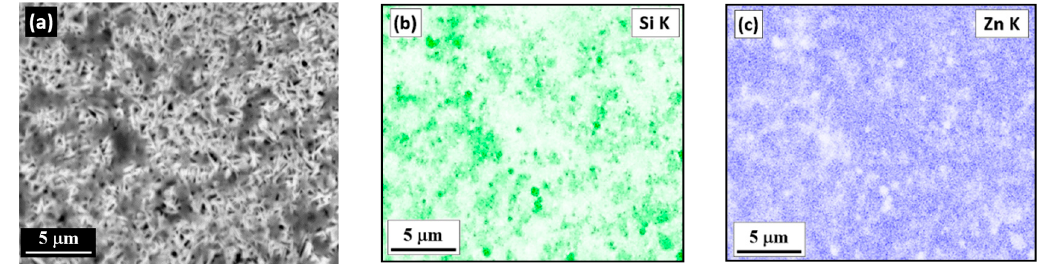
Figure 11. SEM BSE image ( a ) and the corresponding EDS elemental maps of Si ( b ) and Zn ( c ) acquired on the surface of a Zn–SiC layer formed by PED in the presence of gelatin. j avg = − 3.0 A · dm − 2 , f = 100 Hz, and θ = 0.5.